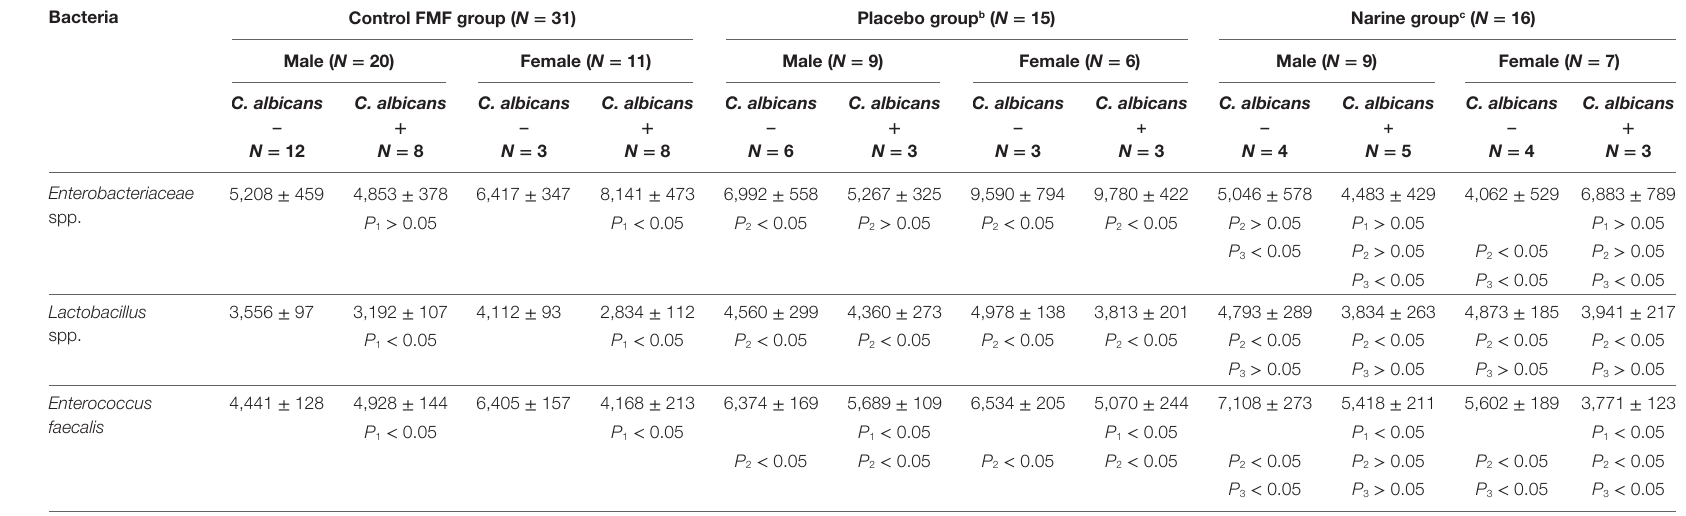
Table 1 | Hybidization scores for gut bacteria in Candida albicans -carrier and non-carrier familial Mediterranean fever (FMF) patients after probiotica a therapy; average ± SD.